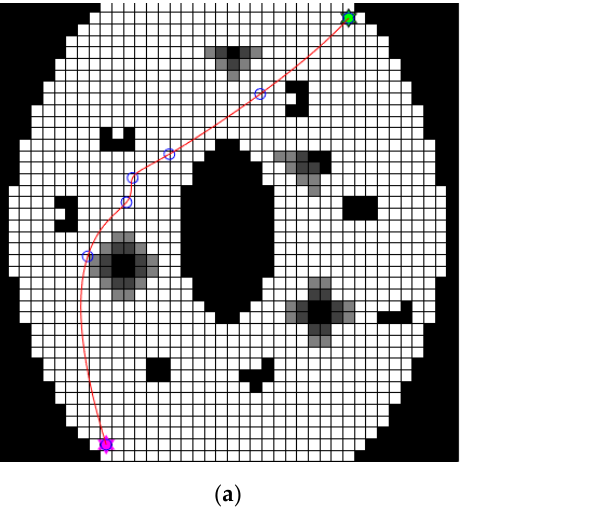
Figure 10. Results of Particle Swarm Optimization Algorithm path planning. ( a ) Simple environ- ment; ( b ) Complex environment.